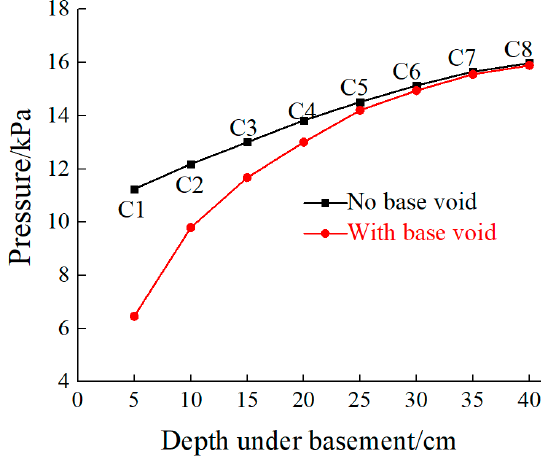
Figure 20. Peak vertical pressure of the soil layer below the tunnel invert.